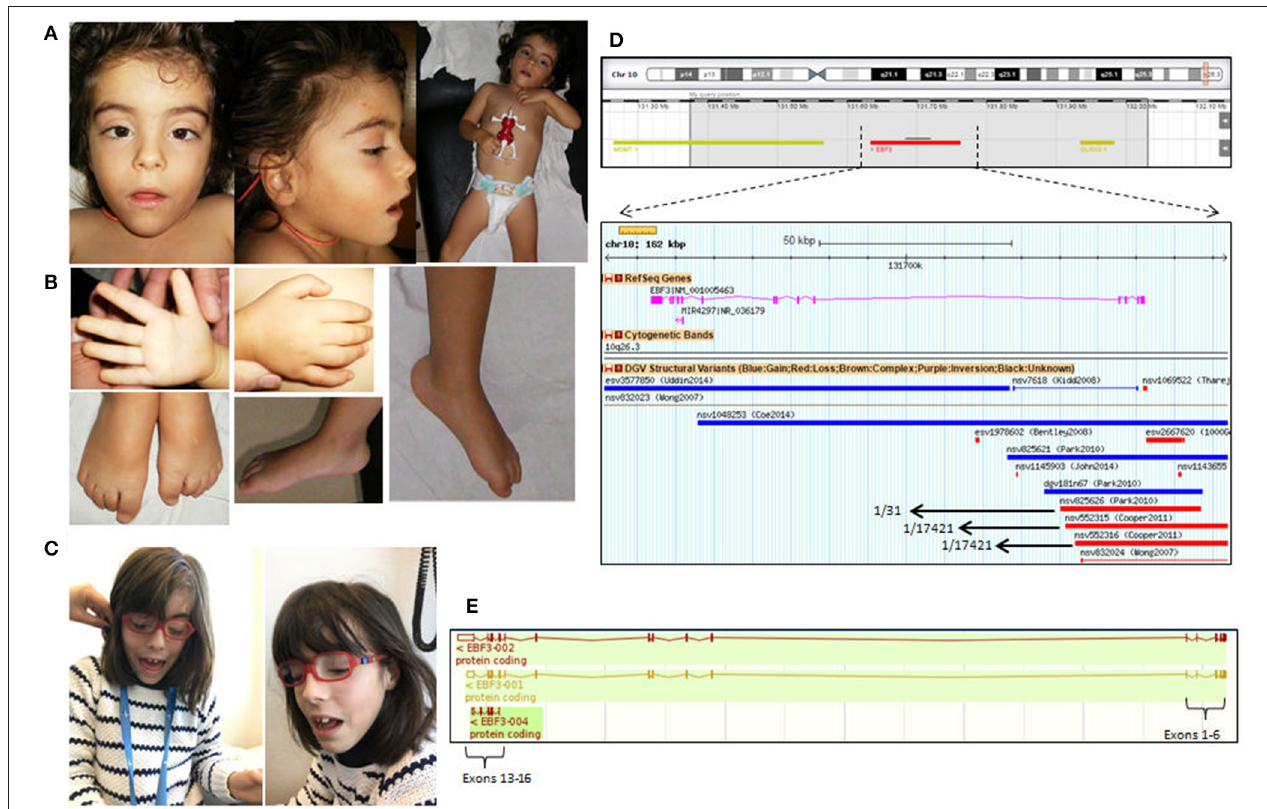
FIGURE 1 | (A) Facial appearance of the patient at 3 years and 5 months showing the small and low-set ears with prominent anti-helix and (B) fetal pads in the fingers. (C) Facial appearance of the patient at 11 years of age. (D) Highlighted in gray the 600Kb deletion at 10q26.3 region; a zoom in of the EBF3 gene in the DGV database reveals the existence of 3 deletions in 3 controls that affect the first 6 exons of EBF3 (NM_001005463); CNVs within this region found in control populations include deletions nvs825626 (present in 1/31 individuals), nvs552315 (present in 1/17421 individuals) and nsv552316 (present in 1/31 individuals). (E) The schematic representation of EBF3